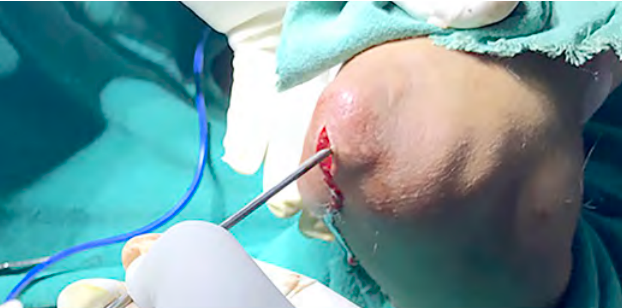
Fig 6 : Antegrade rush pin insertion for ulna